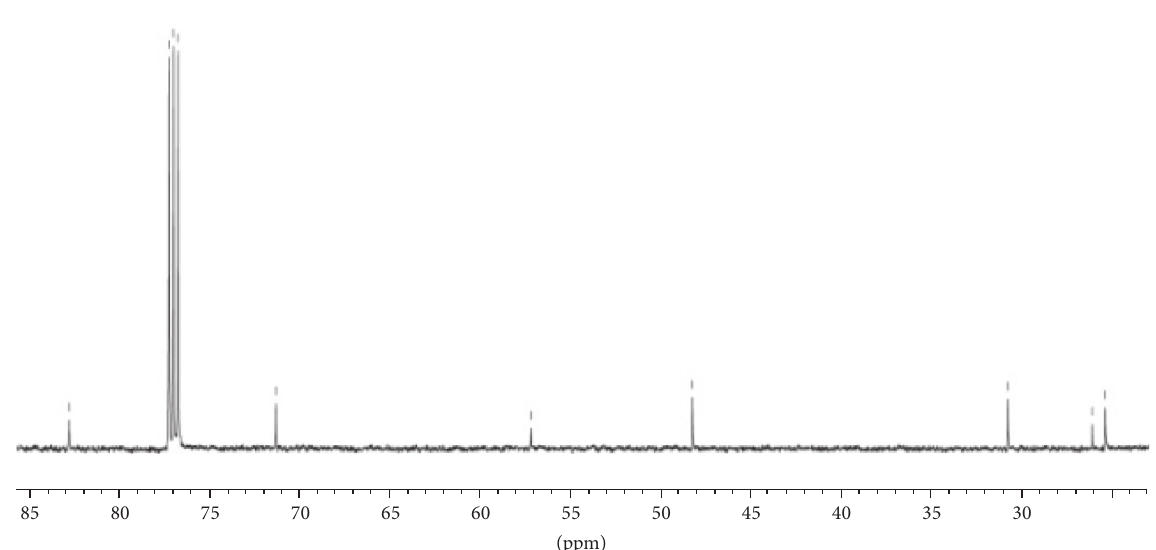
Figure 2: 13 b NMR spectra of compound 4